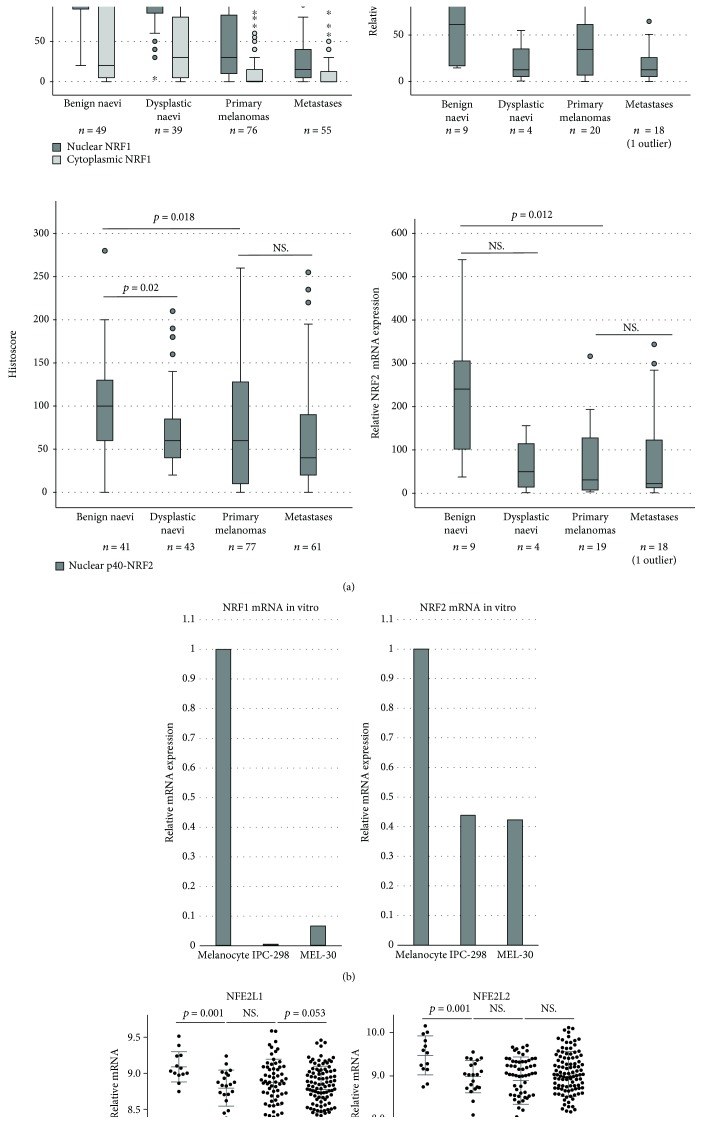
Immunohistochemical and mRNA expression of NRF1 and NRF2. (a) Boxplots representing the Histoscore of the immunohistochemical expression of NRF1 and p40-NRF2 and relative mRNA levels of NRF1 and NRF2 from paraffin-embedded patient samples, (b) expression levels of NRF1 and NRF2 mRNA from representative cell culture samples, and (c) Pooled GEO data from three different cDNA microarray studies including the expression levels of NFE2L1 and NFE2L2 (NRF1 and NRF2). Outliers of the figures are reported.